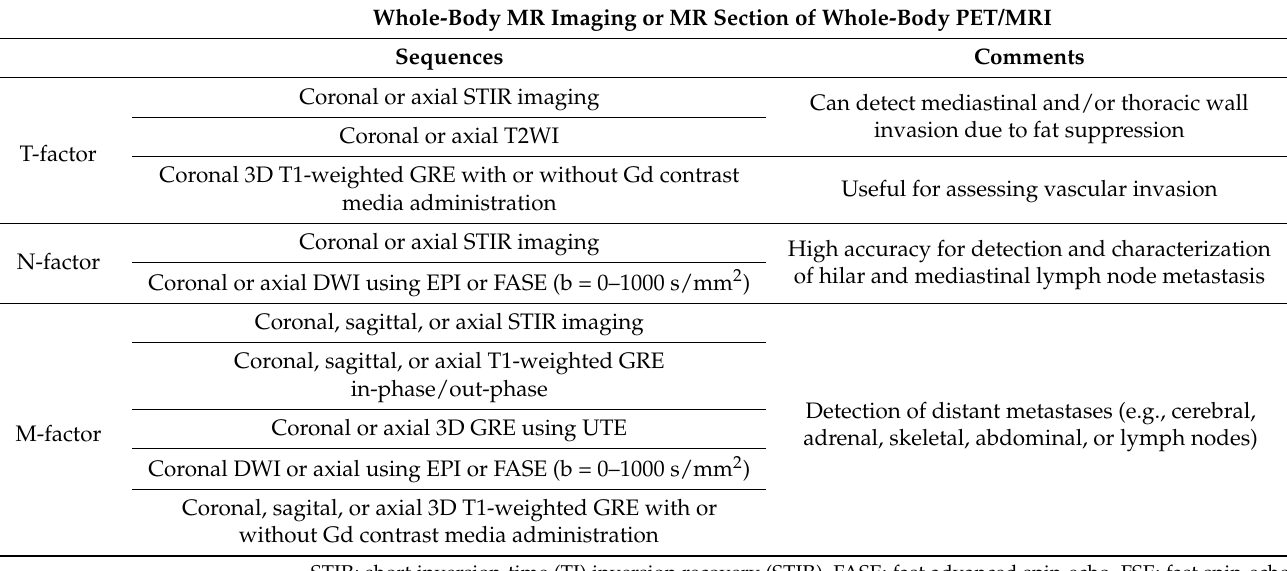
Table 4. Recommended protocols for whole-body MRI or PET/MRI.